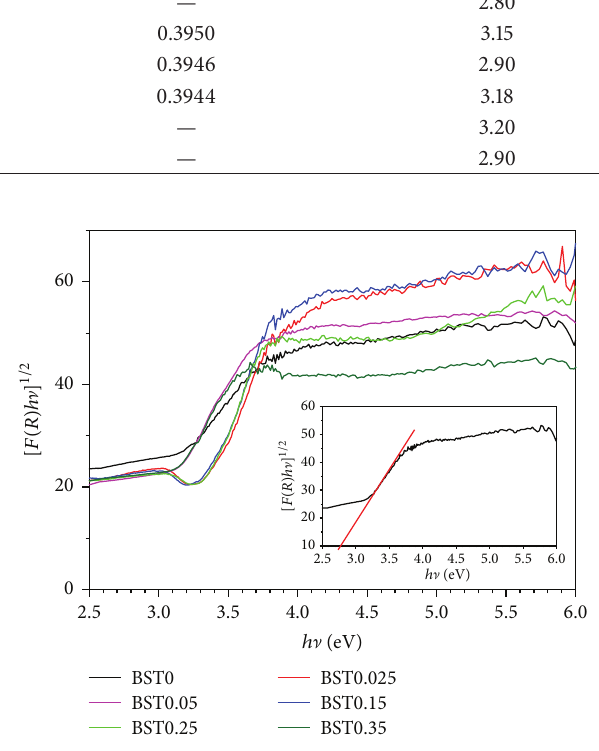
Table 1: Crystallite size, lattice parameter, and indirect band gap of BST powders with various Na contents. Sample